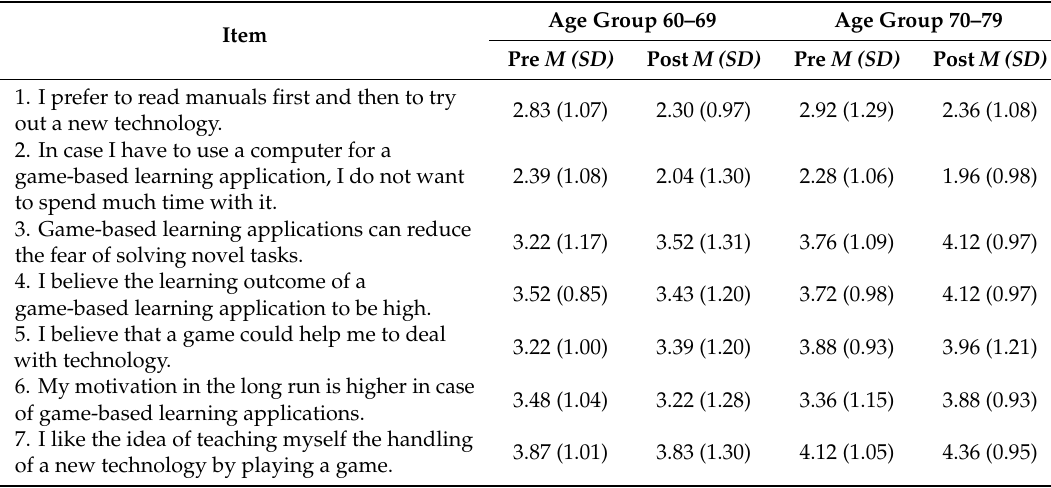
Table 1. Mean ratings and standard deviations of single items measuring participants’ attitude towards interactive learning applications. The response format was a five-point Likert-scale (1 = “disagree”, 2 = “slightly agree”, 3 = “partly agree”, 4 = “strongly agree” 5 = “absolutely agree”).